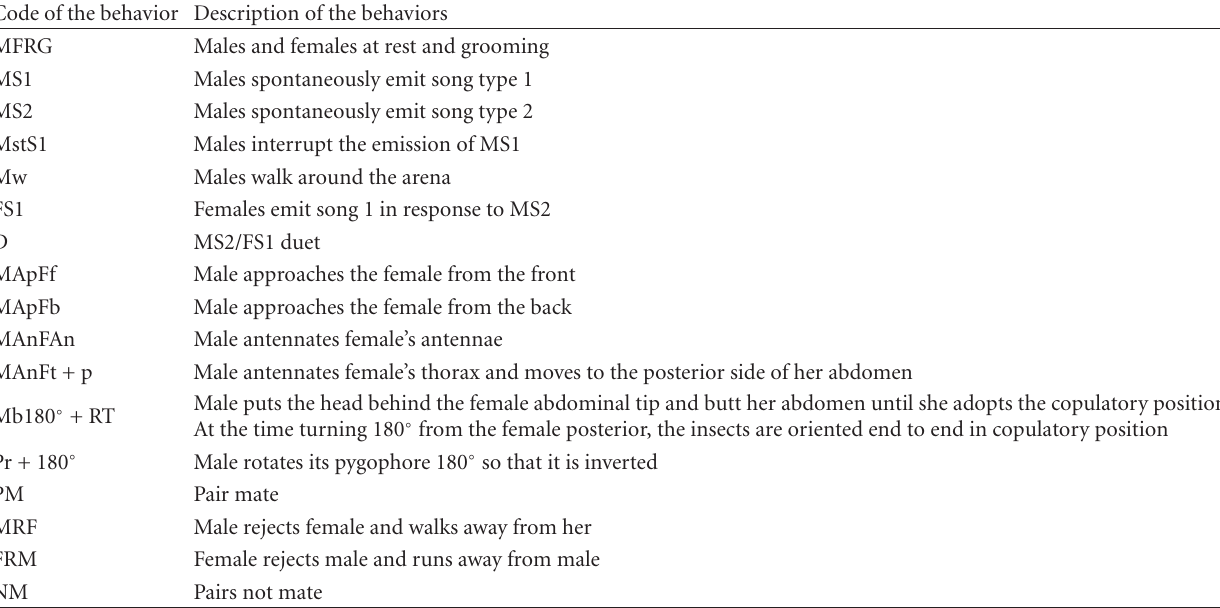
Table 1: Courtship sequence performed by Edessa medidabunda described in the ethogram. Code of the behavior Description of the